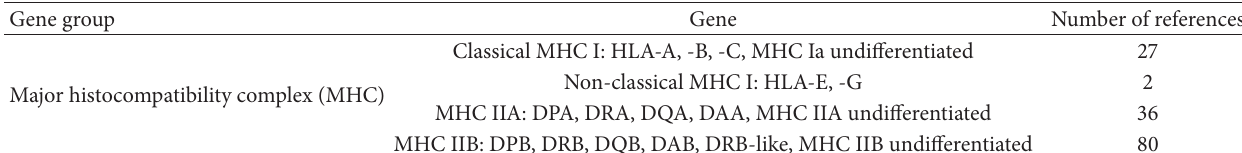
Table 1: Number of published research articles dealing with TSP in vertebrate immune genes available on Web of Science, final update 19 March 2015. For details see Supplement 1.